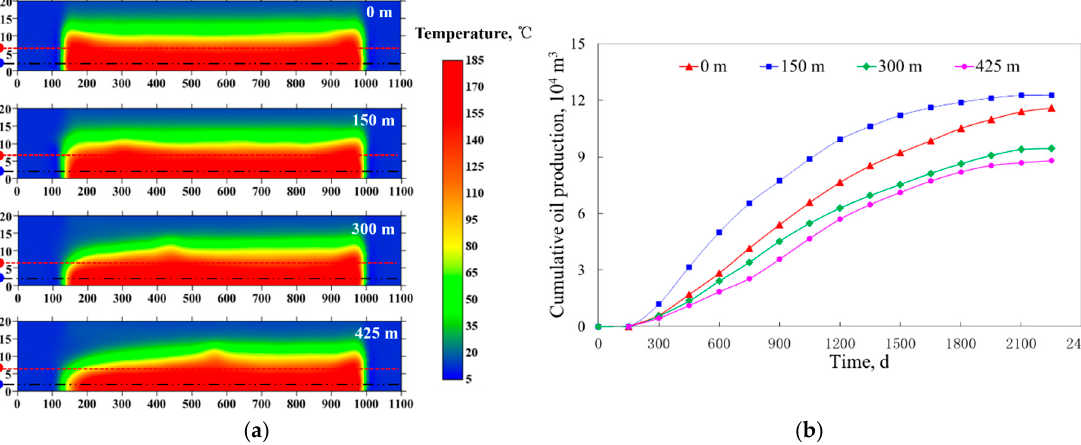
Figure 11. Effect of the injector wellbore configuration on the steam chamber and cumulative oil production: ( a ) steam chamber; ( b ) cumulative oil production.